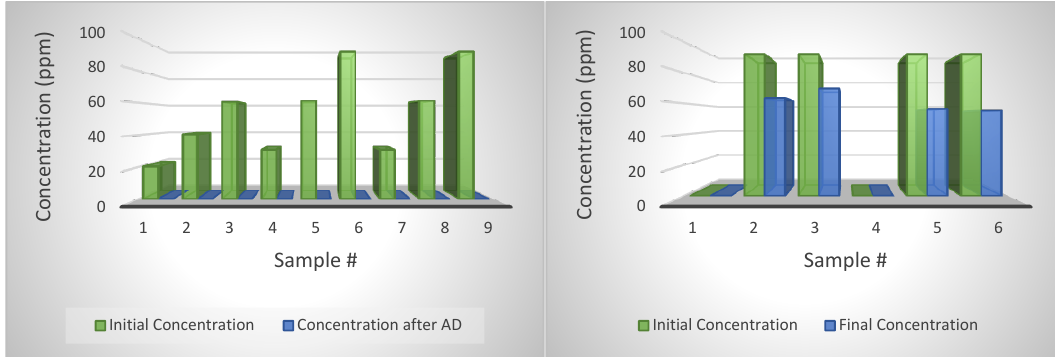
Figure 9. Left : Tylosin concentration change with anaerobic digestion. Right : Tylosin concentration change with reactors filled with diluted water.